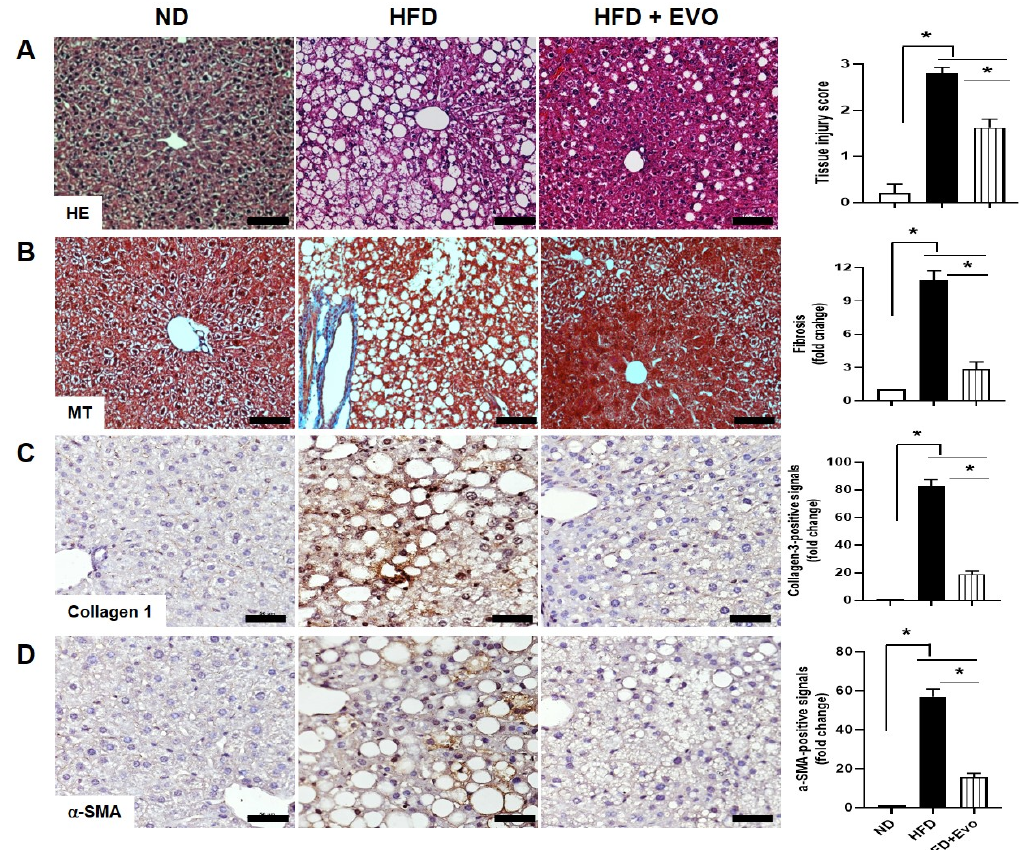
Figure 3. HFD-induced hepatic steatosis and fibrosis were attenuated by evogliptin. Representative liver images from each group by H&E ( A ), MT staining ( B ), collagen-3 ( C ), and α-SMA ( D ). Scale bar, 100 μm for H&E and MT staining. Scale bar, 50 μm for collagen-III and α-SMA staining. Data are means ± SD. * p < 0.05 compared to the indicated groups. HFD: high-fat diet; H&E: haematoxylin and eosin; MT: Masson’s trichrome; α-SMA: α- Smooth Muscle antibody, ND: normal diet.